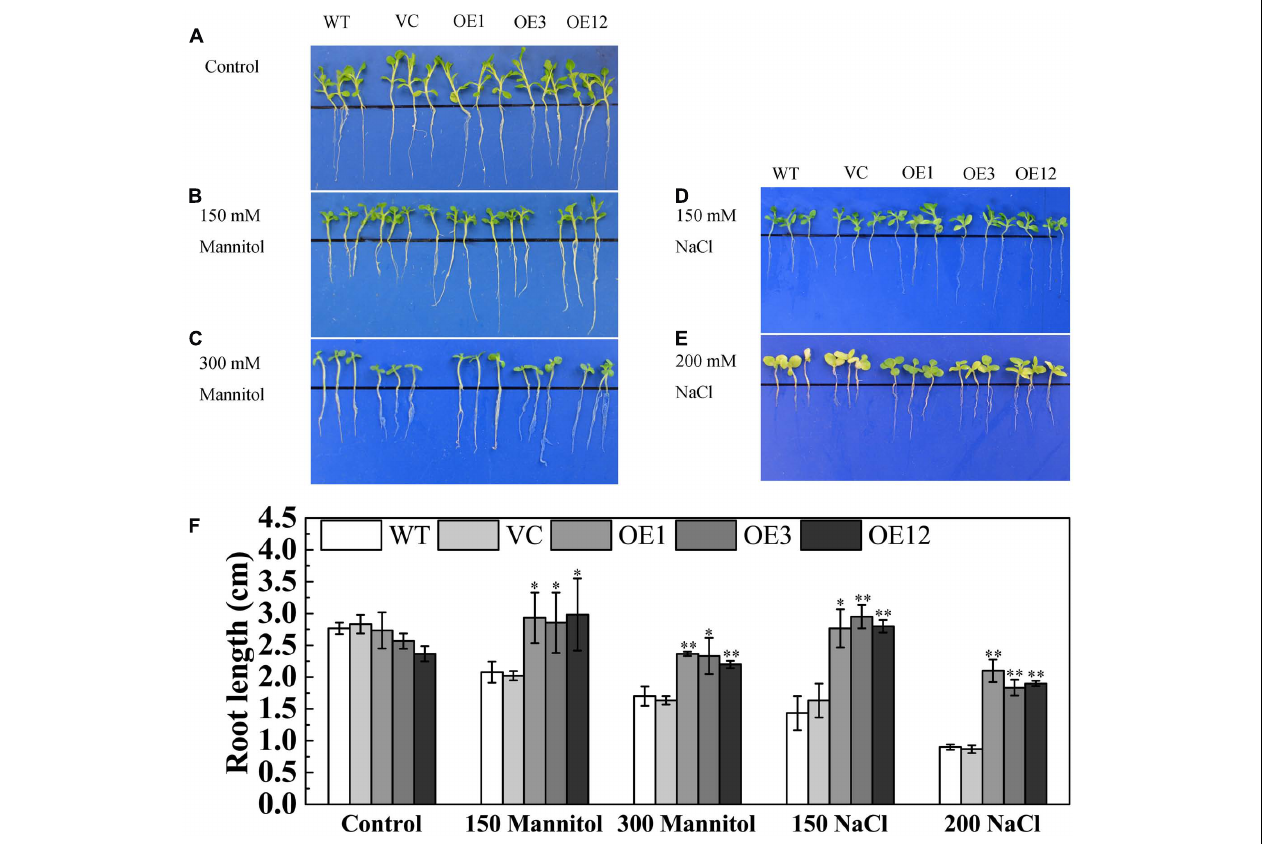
FIGURE 4 | Tolerance analysis of 10-day-old tobacco seedlings. (A–E) Phenotype of seedlings after treatment with mannitol or NaCl for 10 days. (F) Root length statistics of seedlings after treatment with mannitol or NaCl for 10 days. Three independent biological replicates were performed and produced similar results. Vertical bars refer to ± SE ( n = 3). Asterisks indicate significant difference between WT and transgenic lines ( ∗ P < 0.05; ∗∗ P <